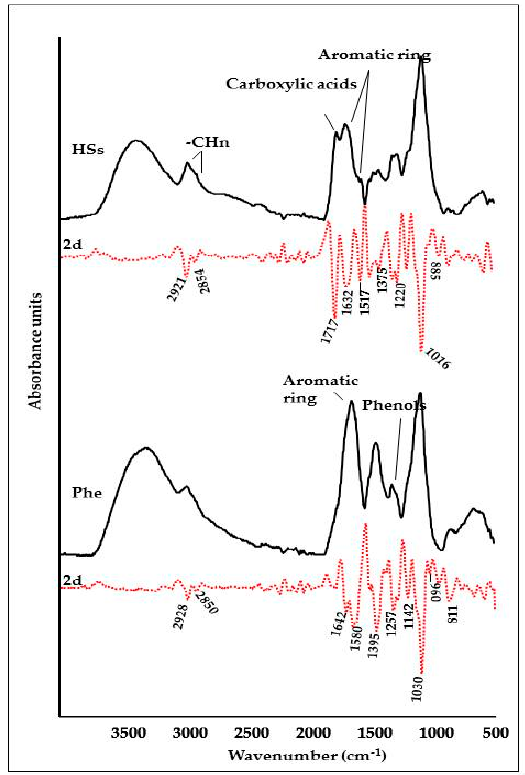
Figure 1. Fourier transform infrared (FT-IR) spectra of humic substances (HSs) and soil water soluble phenolic fraction (SWSP). Dashed lines correspond to second derivative (2d) spectra.